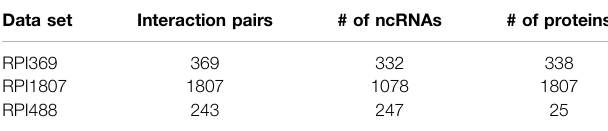
TABLE 1 | The details of the ncRNA-protein interactions datasets. Data